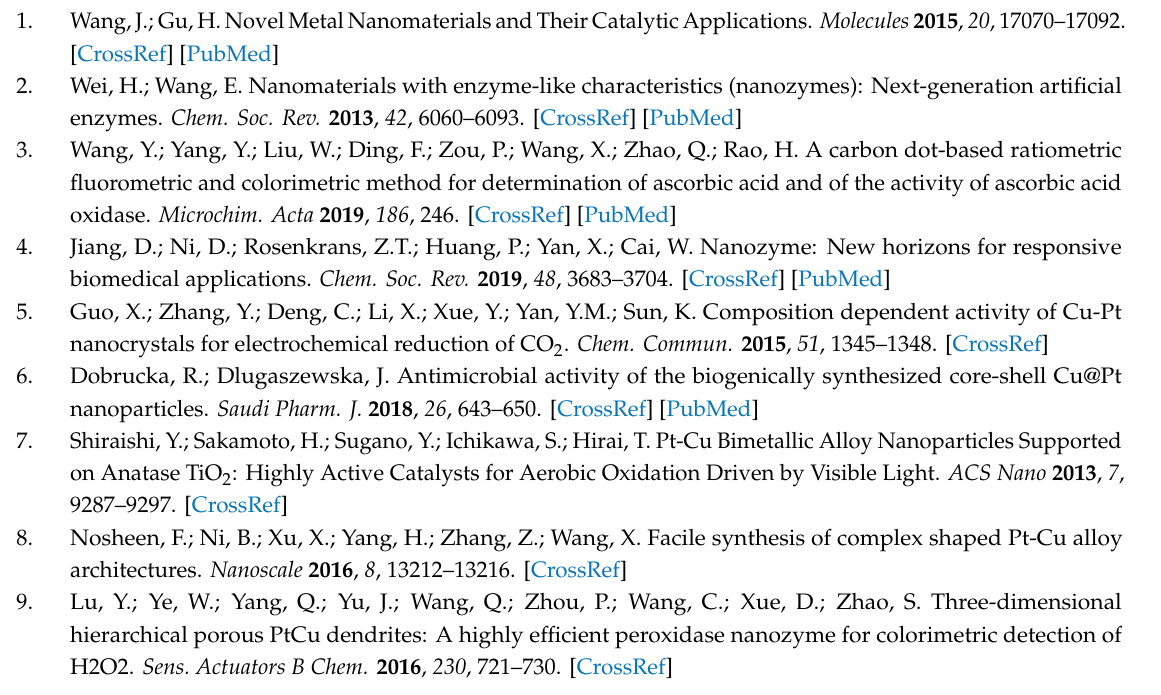
Figure S1: Characterizations of the nanocomposite consisting of Cu and Pt (CuPt), Figure S2: Extinction spectra of OPD in the presence of 1 µ L CuPt in PBS with di ff erent pH, Figure S3: Extinction spectra of OPD with di ff erent concentrations of CuPt in PBS (pH = 3.65), Figure S4: Extinction spectra of AA with di ff erent concentrations of CuPt, Figure S5: UV-Vis-NIR spectra of DPPH after incubation with di ff erent concentration of CuPt without and with histidine. Fiugre S6: Temperature curve of solution containing DPPH and 1 µ L